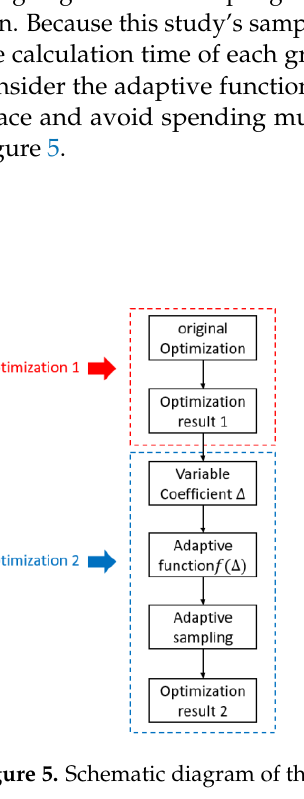
represents the upper and lower i